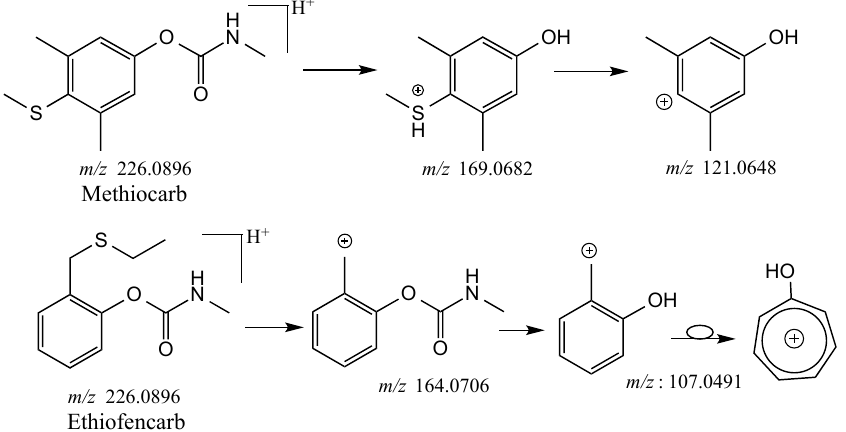
Scheme 3. Proposed pathway for the formation of the differentiation ions for methiocarb and ethiofencarb.